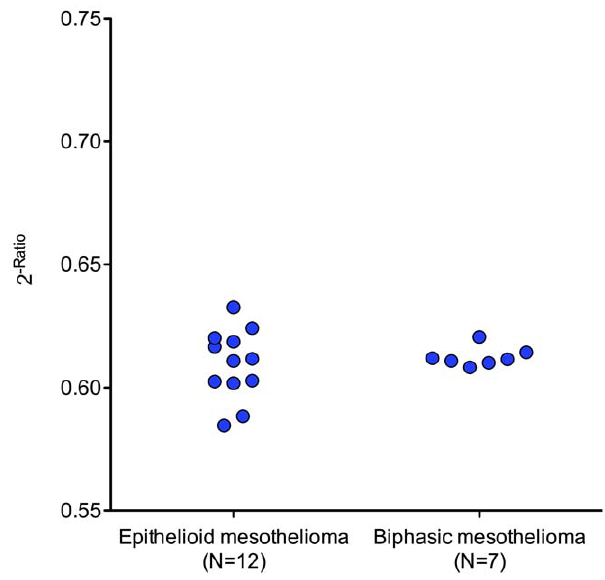
Figure 4. Scatter plot of relative expression of miR-103 in histological subtypes of malignant mesothelioma. Relative expression of miR-103 in the cellular fraction of human peripheral blood of patients with epithelioid and biphasic mesothelioma. One sarcomatoid mesothelioma case and three cases without available histological subtype were excluded from analysis. Expression values were normalized to miR-125a and expressed as 2 2 Ratio .